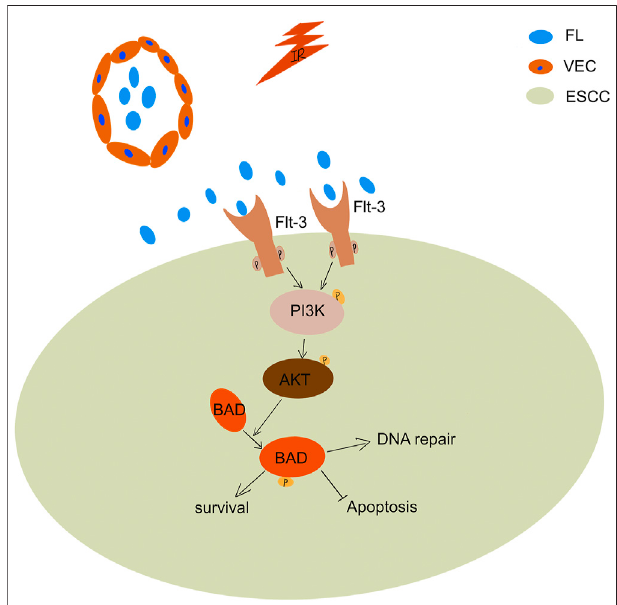
FIGURE 6 | Relevant mechanism of FL mediated the radioresistance of ESCCs during the radiotherapy. Radiation signi fi cantly increase Flt-3 receptor expression in ESCCs. FL phosphorylate the increased Flt-3 receptor, which further activate the PI3K/Akt pathway leading to BAD